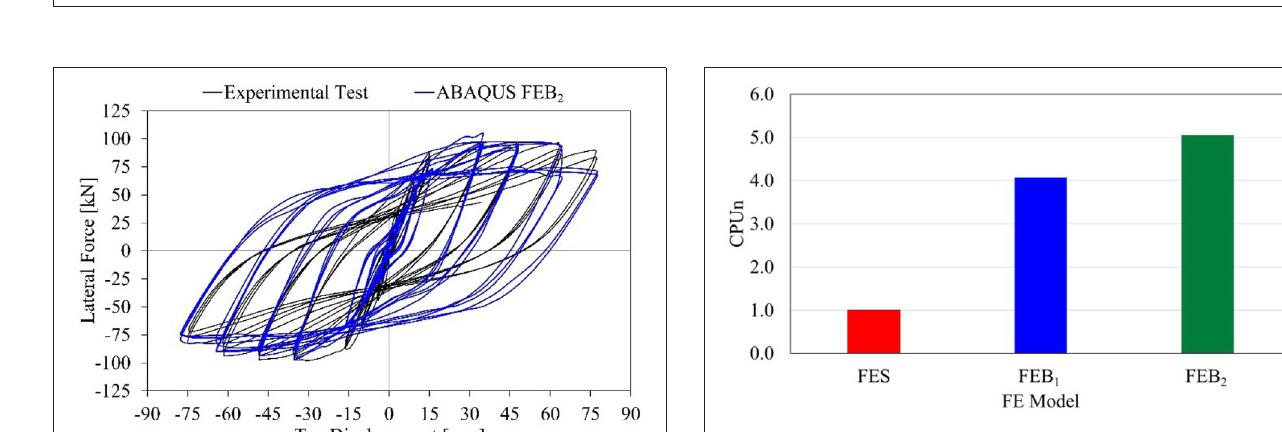
FIGURE 13 | CPU time comparison between FES, FEB 1 , and FEB 2 . TABLE 2 | Total energy dissipated for experimental test and numerical models referring to